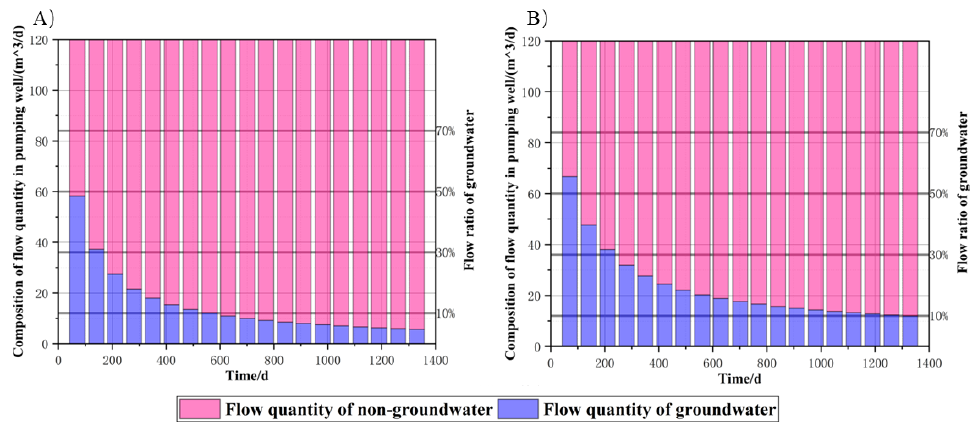
Figure 6. The bar graph of the composition of flow quantity in pumping wells at the whole C1 and C2 mining areas with the change in time (based on the average concentration from all pumping wells). Note: ( A ) ‐ Plan A; ( B ) ‐ Plan B. Table 1. Comparison of the day for plan A and plan B to reach the corresponding “flow ratio of groundwater”.